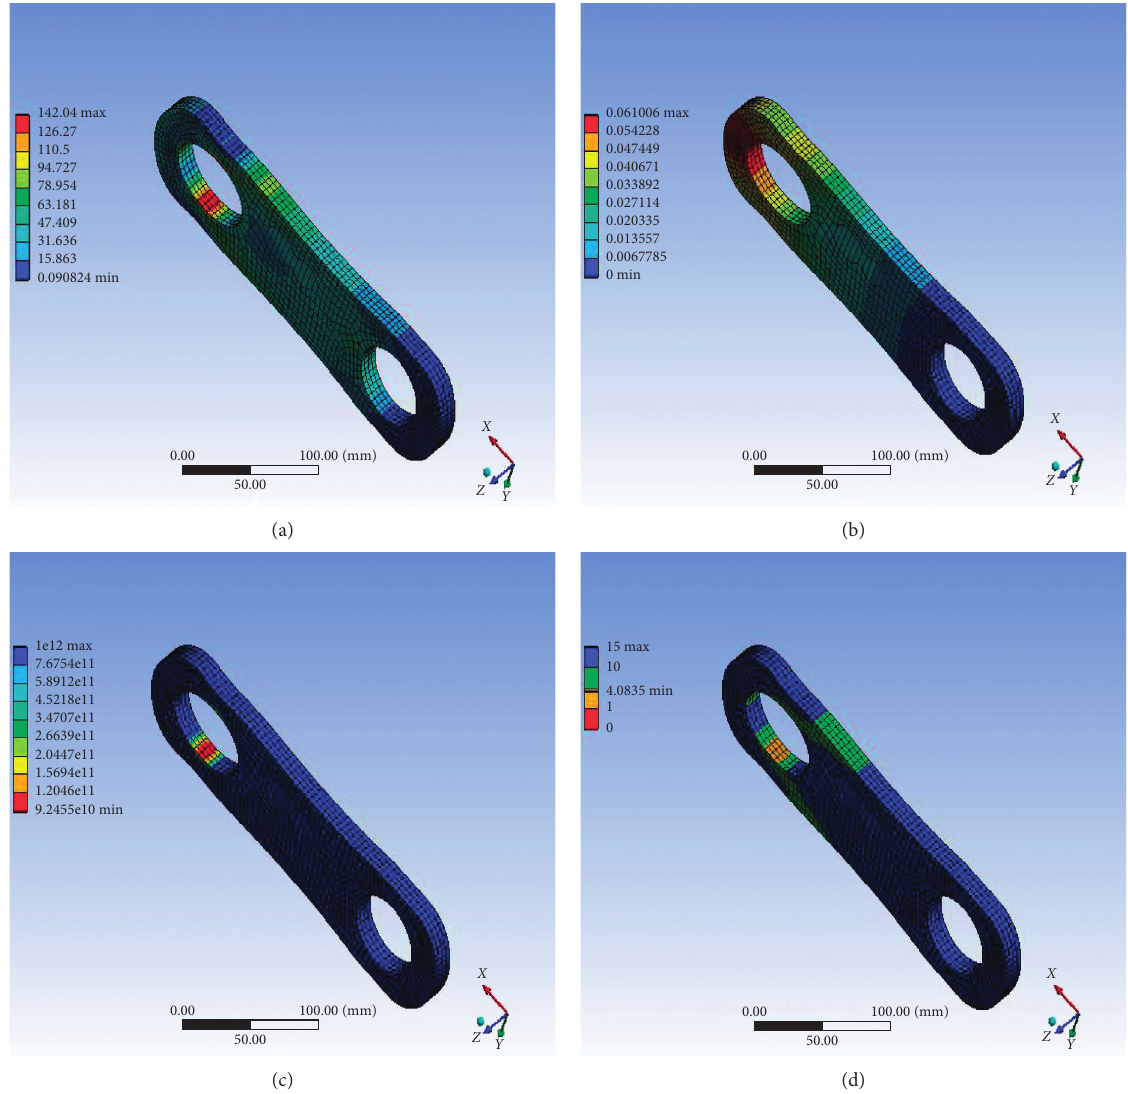
Figure 12: Simulation results for chain link without a modeled crack with neck radius 2488.4mm ( X � 5mm): (a) equivalent stress, (b) deformation, (c) fatigue life, and (d) safety